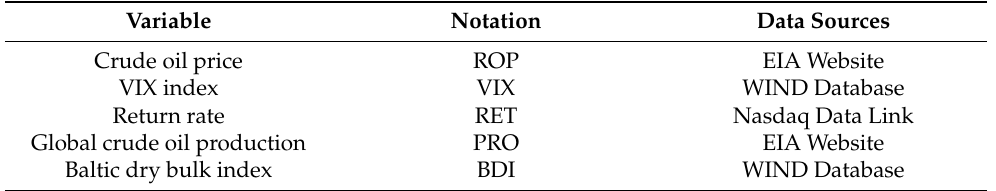
Table 1. Main variables and data